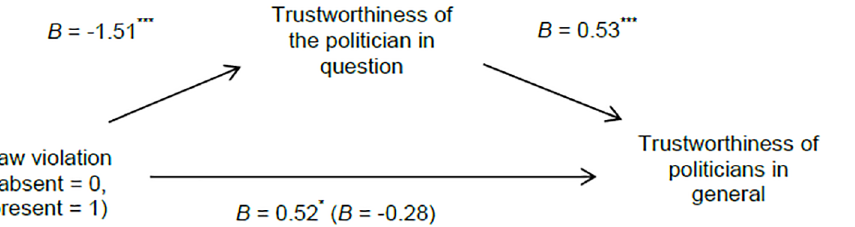
Figure 2. Indirect effect of the experimental condition on the perceived trustworthiness of politicians in general mediated by the perceived trustworthiness of the involved politician in Study 3. Note. N = 139. The figure displays unstandardized regression coefficients. The number in parentheses represents the coefficient for the total